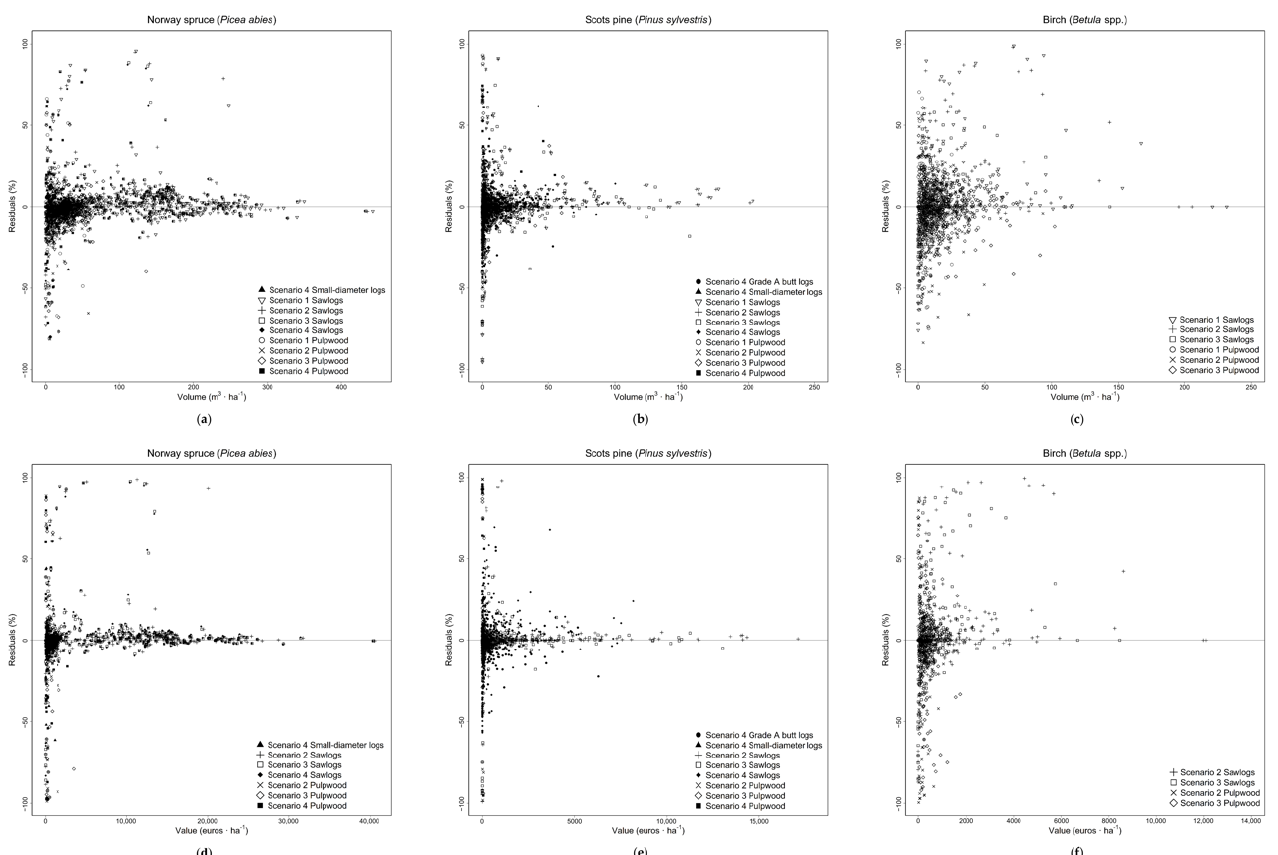
Figure 3. Residual errors for the timber assortment volumes for Norway spruce ( a ), Scots pine ( b ) and birch ( c ), and values for Norway spruce ( d ), Scots pine ( e ) and birch ( f ).